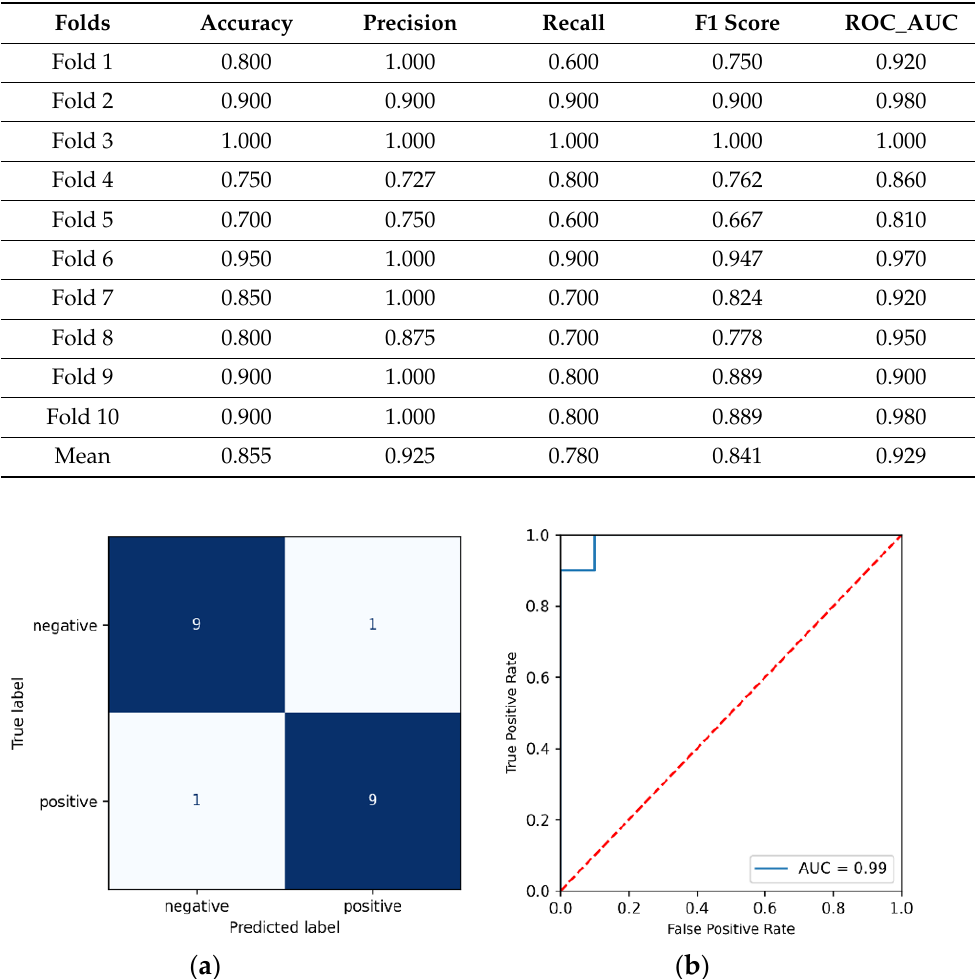
Figure 5. ( a ) Confusion Matrix for Gaussian Process Classifier with 7 principal components ( b ) Area Under Curve Receiver Operating Characteristics (AUC_ROC) for Gaussian Process Classifier with 7 principal components.